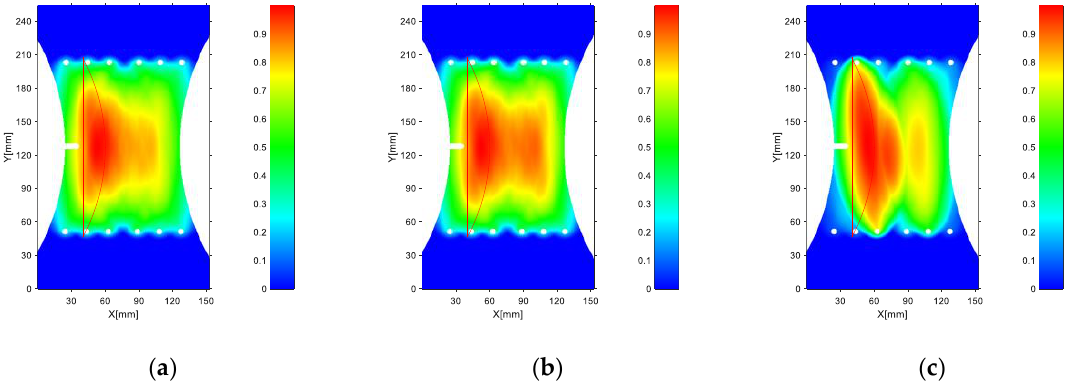
Figure 21. Imaging results with different damage factors at a signal-to-noise ratio of 0.1 dB: ( a ) energy damage factor; ( b ) cross-correlation damage factor; ( c ) sparse representation damage factor.